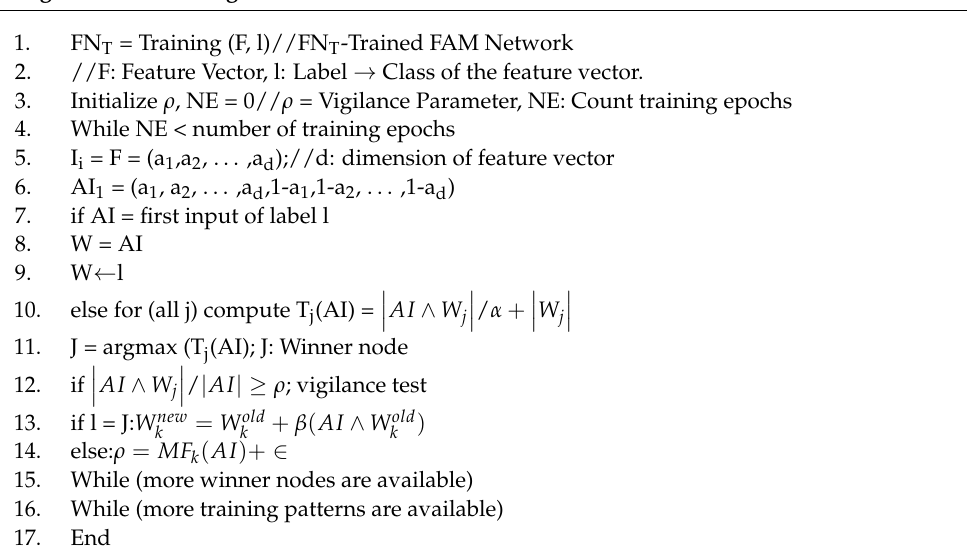
Algorithm 1: Training FAM